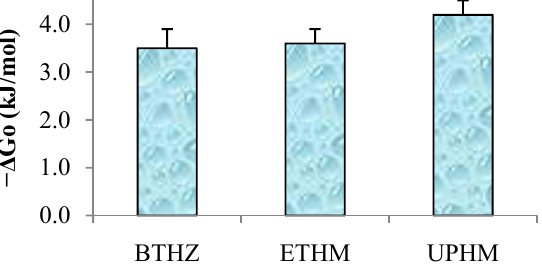
Figure 3 . Thermodynamic stability expressed as Gibbs free energy ( Δ G o ) of the solutions containing maximum levels of calcium and phosphate ions released from BTHZ/ACP, ETHM/ACP and UPHM/ACP composites. Number of samples in each group n = 3. Negative Δ G o values indicate solutions supersaturated with respect to stoichiometric